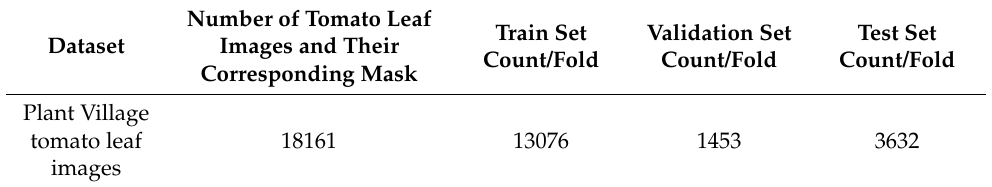
Table 3. Summary of the U-net segmentation experiment.